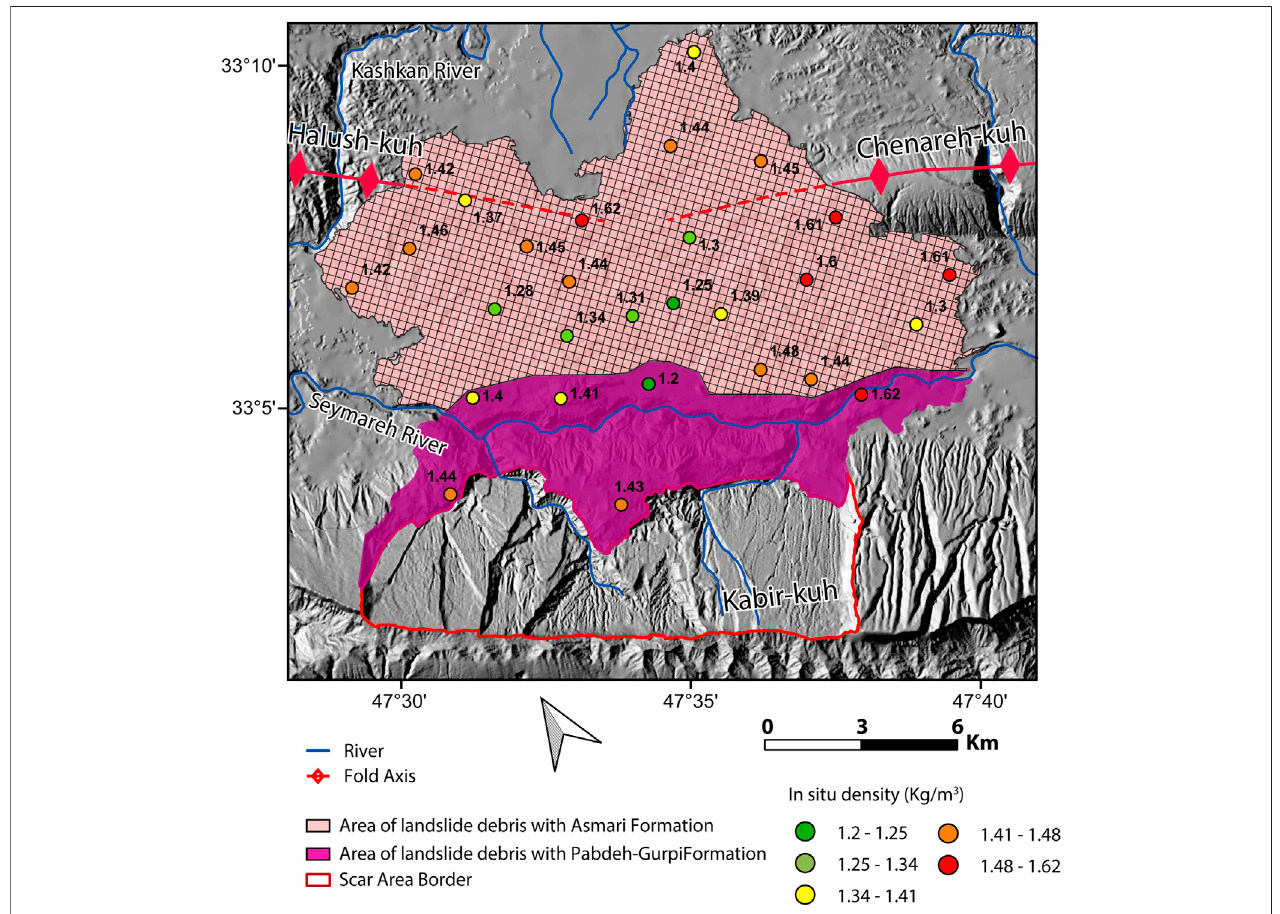
FIGURE6| Locationsofthe28 insitu densitymeasurementsontheSeymarehlandslidedebris.Theobtainedvaluesarereported.Theareasofthelandslidedebris with Asmari Formation and with Pabdeh – Gurpi Formation are shown according to Roberts and Evans (2013). The coordinate reference system is WGS84.